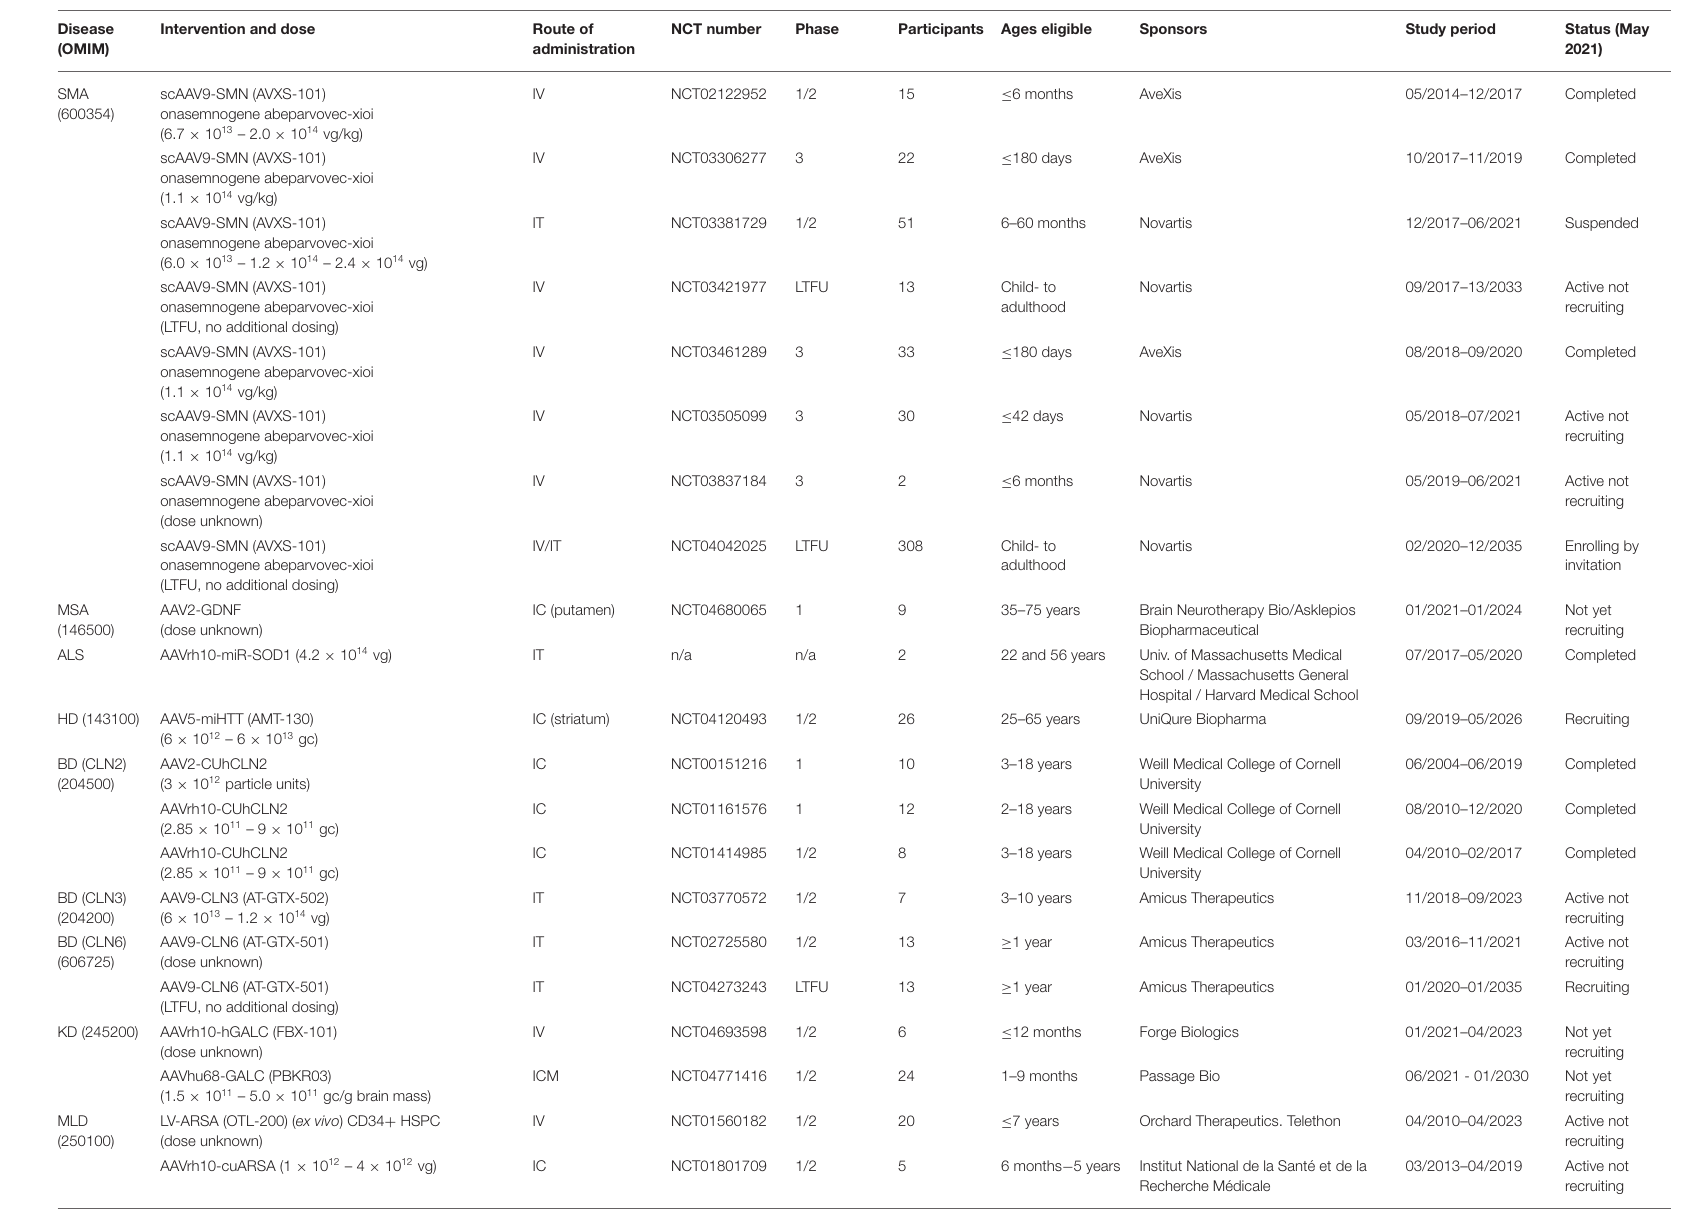
TABLE 2 | Overview of clinical gene therapy trials for rare genetic diseases affecting the brain and spinal cord found on https://clinicaltrials.gov 1st of May 2021. Disease Intervention and (OMIM)